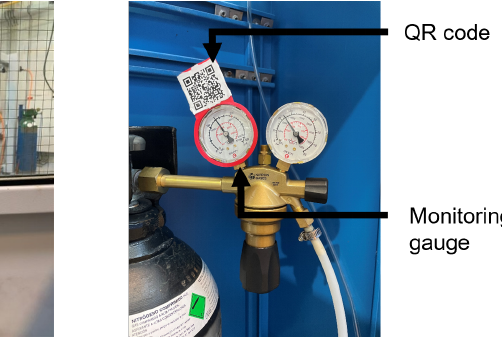
Figure 18. Setup of the IoT